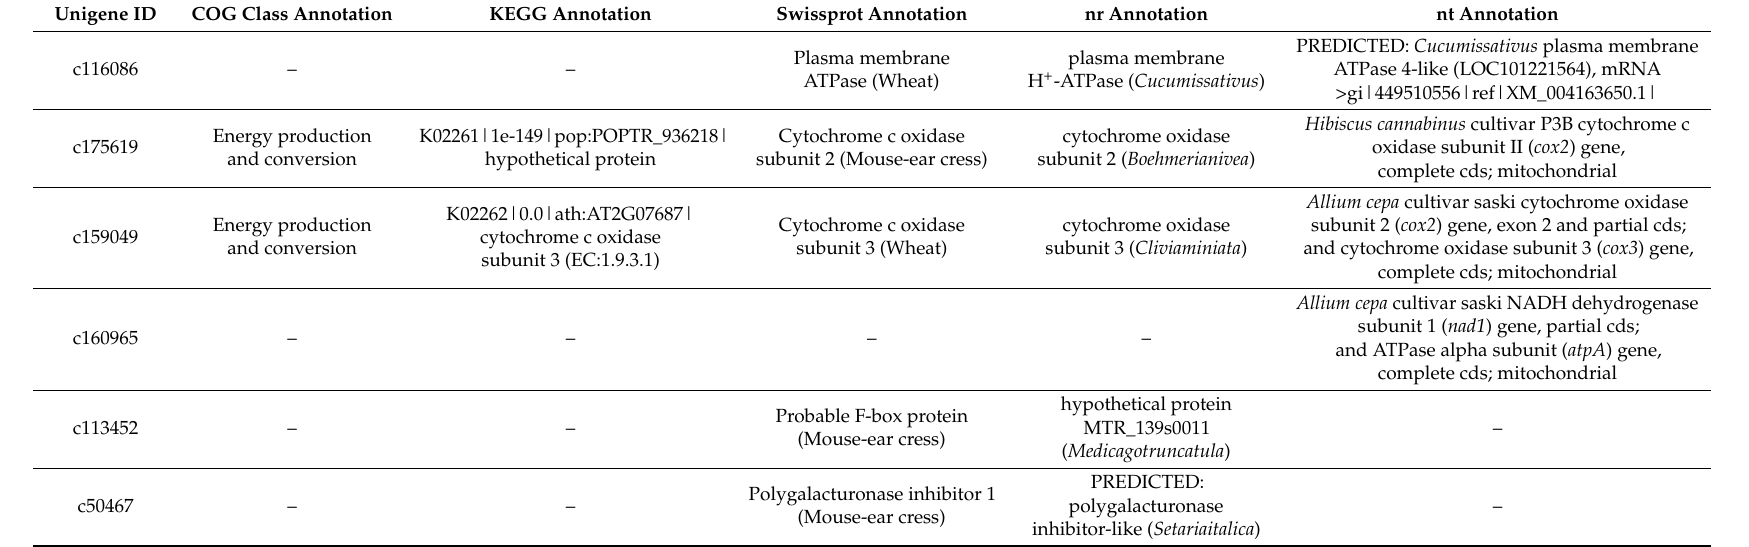
Table 3. The unigenes associated with Cytoplasmic male sterility